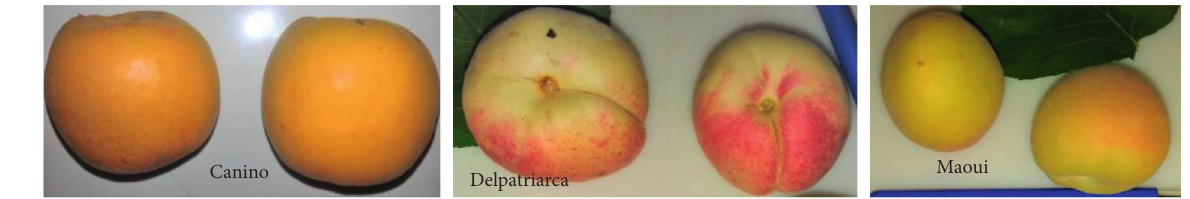
Figure 1: The three studied apricot cultivars: “Canino”, “Delpatriarca,” and